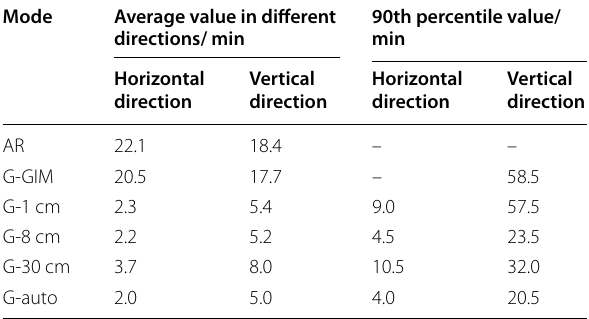
Table 3 Average and 90-percentile convergence time for “G-auto”, “GE-auto”, and “GE-auto R” +